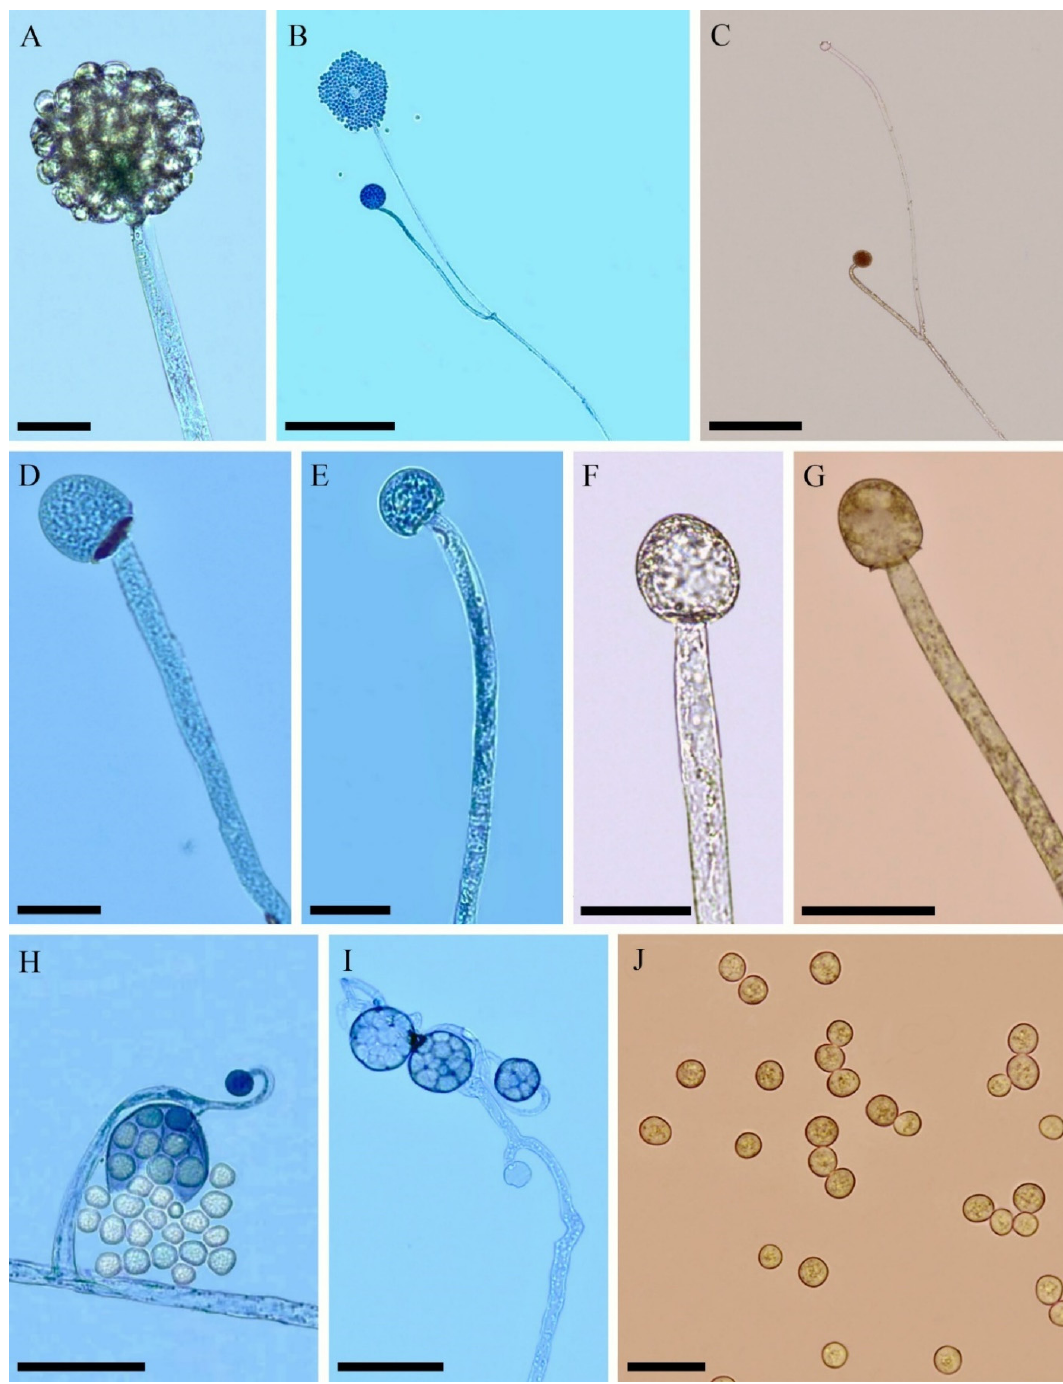
Figure 3. Backusella obliqua (URM 8427): ( A ) sporangiophore with sporangium; ( B ) branched sporangiophore with sporangia; ( C ) branched sporangiophore with sporangium and columella; ( D – G ) sporangiophore with columella; ( H ) short-branched sporophore bearing uni- and multispored sporangiola; ( I ) short-branched sporophore bearing only multispored sporangiola and columella; and ( J ) sporangiospores. Scale bars: ( A , D – G , J ) = 25 μ m; ( B , C ) = 200 μ m; ( H , I ) = 50 μ m.